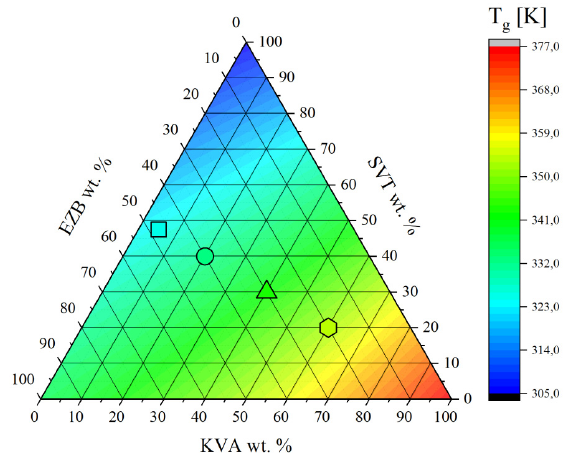
Figure 5. Variation of glass transition temperature in the ternary phase diagram of EZB/SVT/KVA. Table 1. Comparison of T e , T l , T g exp , and T g pred values of pure KVA, the binary mixture of EZB/SVT, as